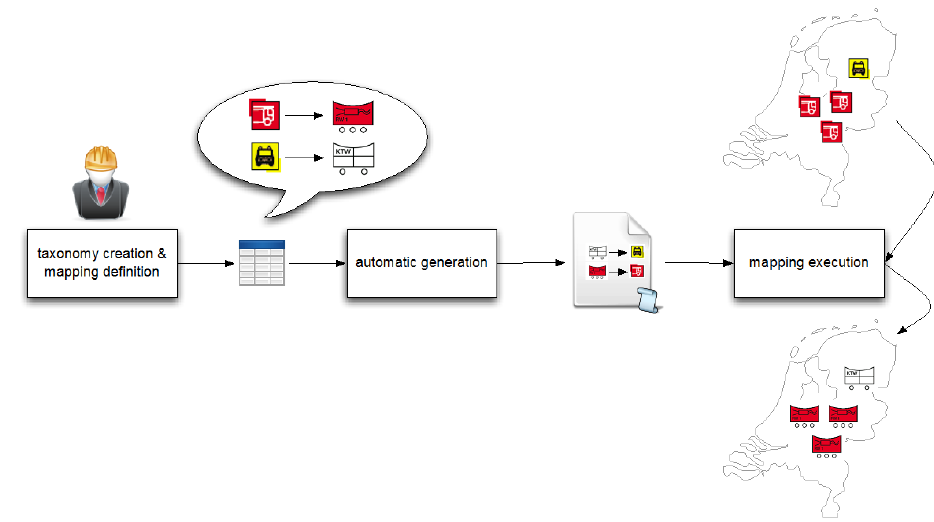
Figure 3. Processes involved in symbology translation applied to situational information maps for emergency responders.